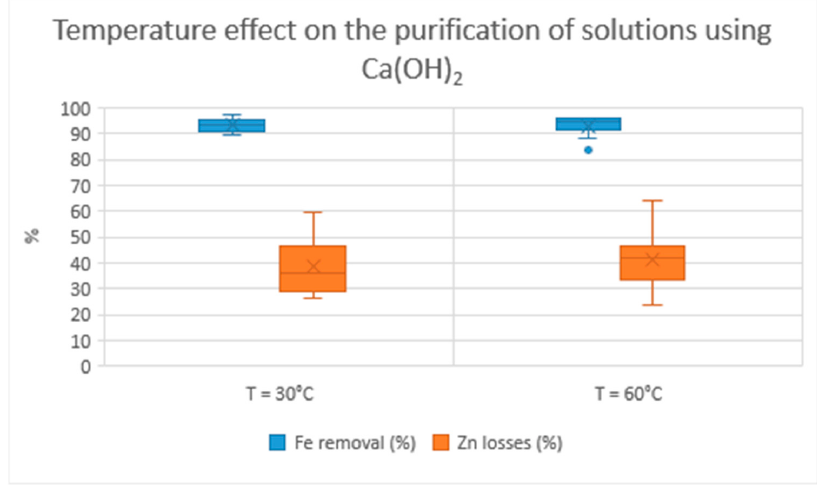
Figure 14. Temperature effect on the purification of solutions using Ca(OH) 2 .